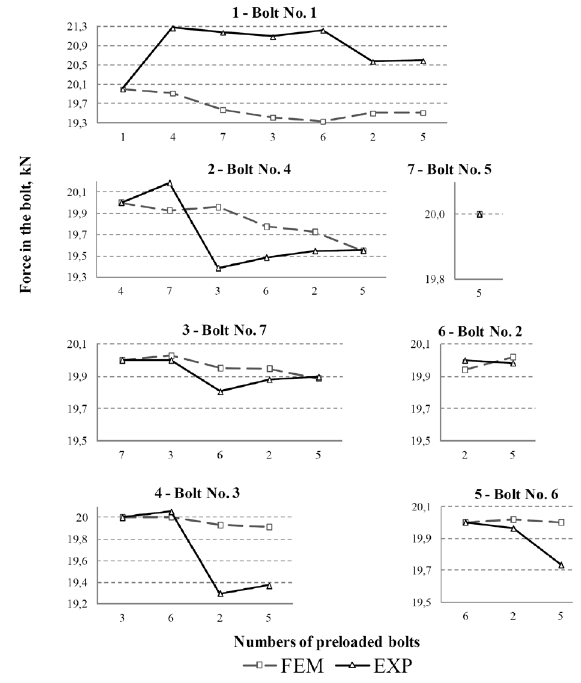
Fig. 5. Preload values during the assembly process Rys. 5. Wartości napięcia wstępnego śrub podczas montażu